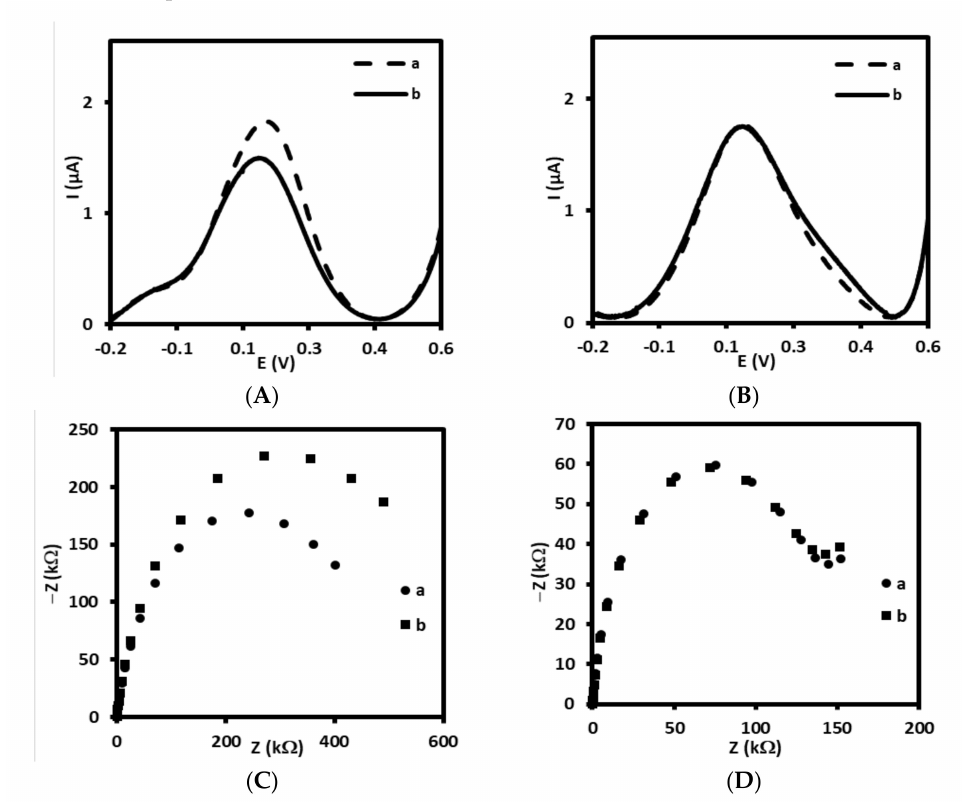
Figure 1. Square wave voltammograms and Nyquist plots recorded for immunosensor based on antibody immobilized on: ( A , C ) 4-ATP linker (a) before and (b) after interaction with 0.144 µ M of LDL and ( B , D ) 4-MBA linker (a) before and (b) after interaction with 0.144 µ M of LDL, recorded in PBS (pH 7.4) with 1 mM [Fe(CN) 6 ] 3 − /4 −